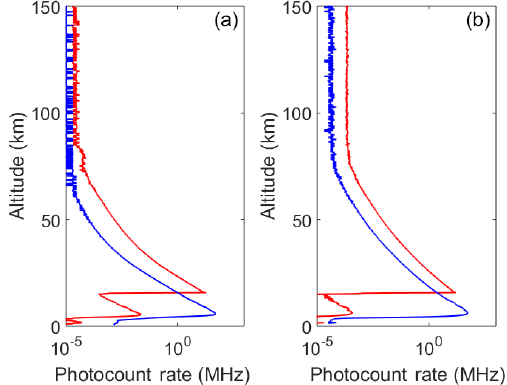
Figure 2. Average count rates for 5h of measurements on 26 July 2017. (a) Online wavelength (blue curve, low altitude; red curve, high altitude). (b) Off-line wavelength (blue curve, low alti- tude; red curve, high